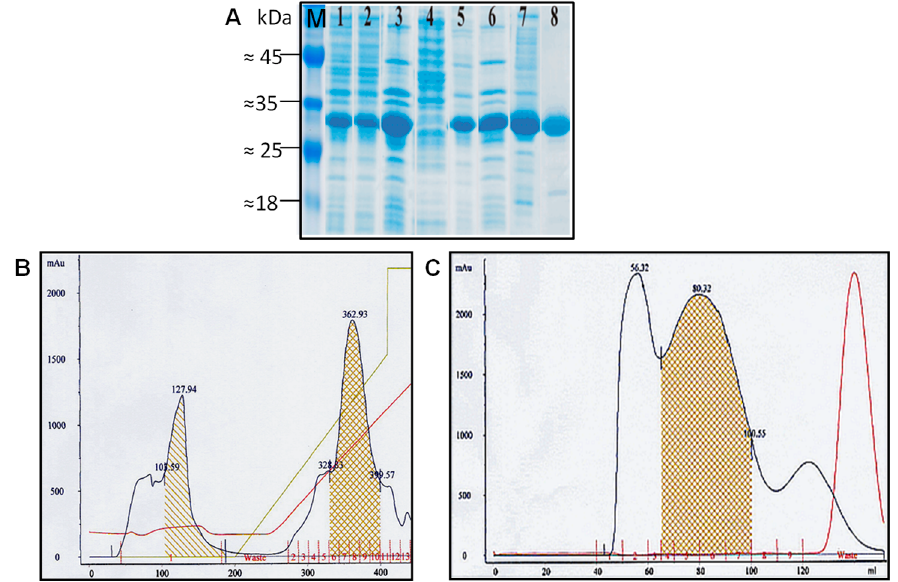
Figure 4 . The purification of 183preS1phil VLPs. ( A ) SDS-PAGE of fractions from the entire puri- fication process, staining with Coomassie Brilliant Blue G-250: M - Pierce™ Prestained Protein MW Marker (cat N 26612, Thermo Fisher Scientific Baltics UAB, Vilnius, Lithuania), lane 1 — crude cell lysate (after French press), lanes 2, 3 — extraction with 1M urea: lane 2 — supernatant, lane 3 — debris; lane 4 — supernatant after precipitation with 35% ammonium sulfate (AS); lanes 5, 6 — extraction with 1M urea of the precipitate after 35% AS: lane 5 — soluble part, lane 6 — insoluble part; lane 7 — central peak fractions from Fractogel EMD DEAE (see second peak on ( B )pooled fractions for GF are shown cross-striped and colored in brown); lane 8 — central peak fractions from GF on Sepharose 4 FF (see ( C ), pooled fractions are shown crossed-striped and colored in brown. ( B ) Fractogel EMD DEAE chromatography; ( C ) GF on Sepharose 4 FF. In ( B ) and ( C ) X-axis show mL, Y-axis – optical density (OD, A 254 ) in adsorption units (mAu); analyzed fractions are shown under the peaks and are red colored; blue line shows OD, red line shows conductivity and green line shows NaCl gradient at elution study. Left part in ( B ) shows that the capacity of the column was exceeded and part of target protein was not loaded (shown